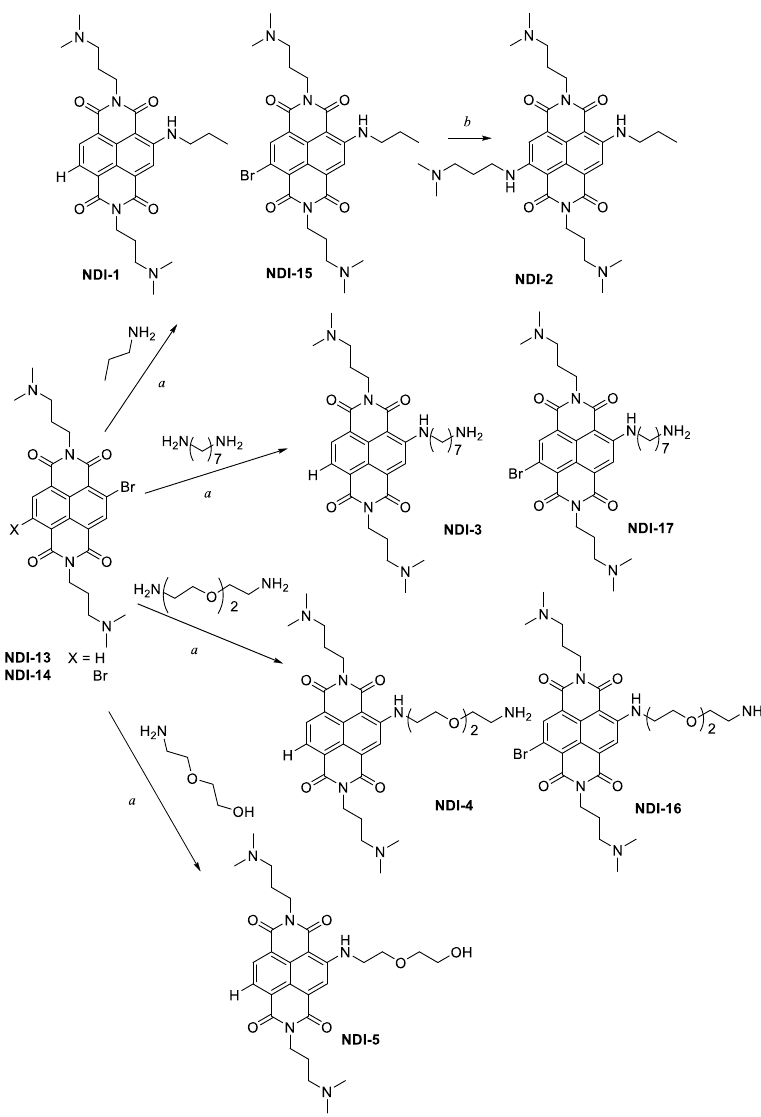
Figure 3. Synthesis of the monomeric NDIs: the letter a denotes 2.5 equivalents of the opportune amine in CH 3 CN, 75 °C, 2 h; the letter b denotes NDI-15 was treated in neat N 1 , N 1 -dimethylpropane-1,3-diamine, 150 °C, 3 min, closed-vessel microwave-assisted.